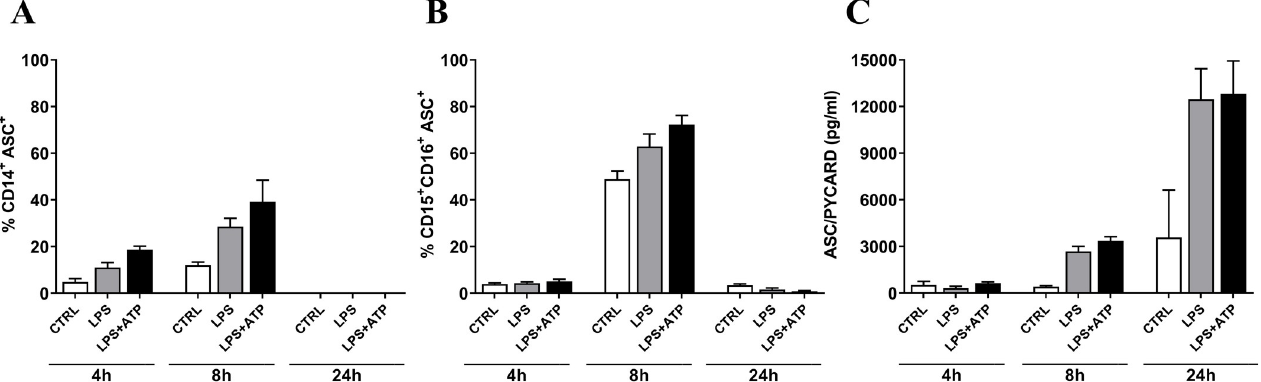
Fig 3. ASC detection in whole blood. Percentage ASC expression for each stimulation conditions (CTRL: open bars, LPS: grey bars, LPS+ATP: black bars) after 4, 8 and 24h in CD14 + monocytic population ( A ) and CD15 + CD16 + neutrophil population ( B ). ( C ) ASC/PYCARD detection in plasma upon inflammasome activation with LPS or LPS+ATP. Data are expressed as mean value ± SEM of each stimulation condition, n = 2 ( A, B ) and n = 6 ( C ).